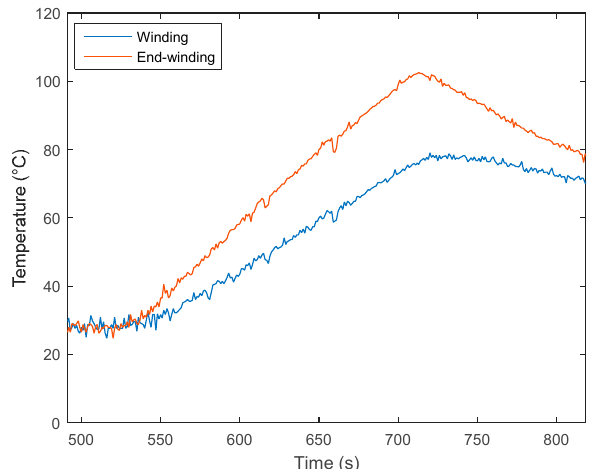
Figure 14. Rising temperatures of operating point of peak torque at 1000 rpm.